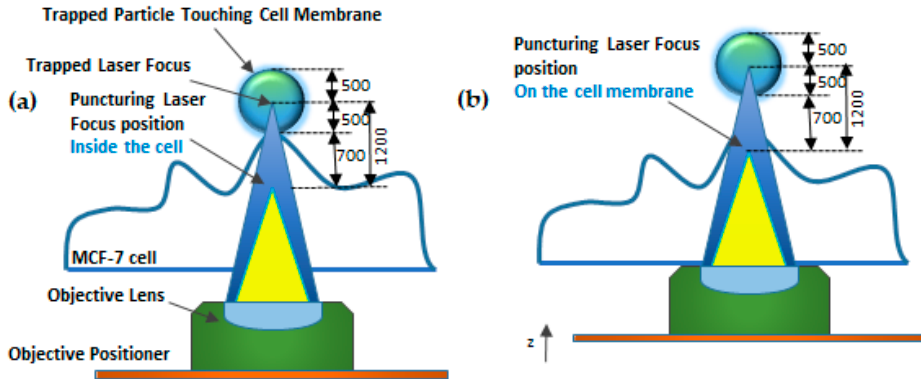
Figure 20. Schematic diagram of Focused Laser Beam Single-cell Optoporation. ( a ) 1064 nm laser (blue) as an optical tweezer to trap particle. ( b ) An 800-nm femtosecond laser (yellow) used as a puncturing laser for membrane disruption. Figure has been redrawn from ref. [144].